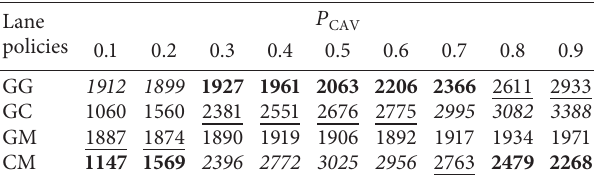
Table 4: Road capacity with different P freeways).